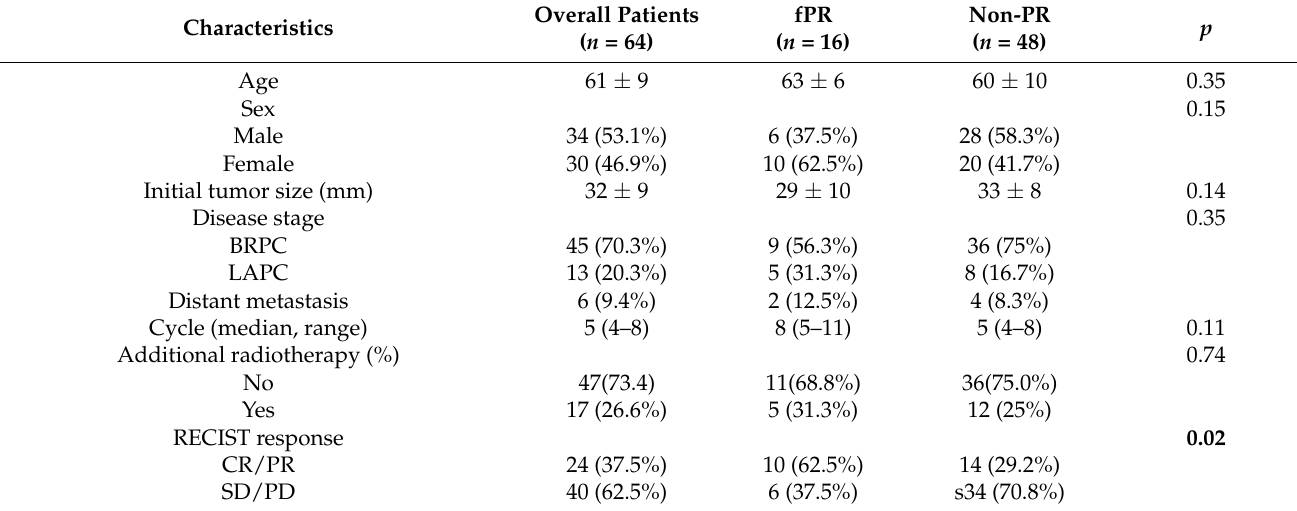
Table 1. Clinicopathological characteristics ( n =